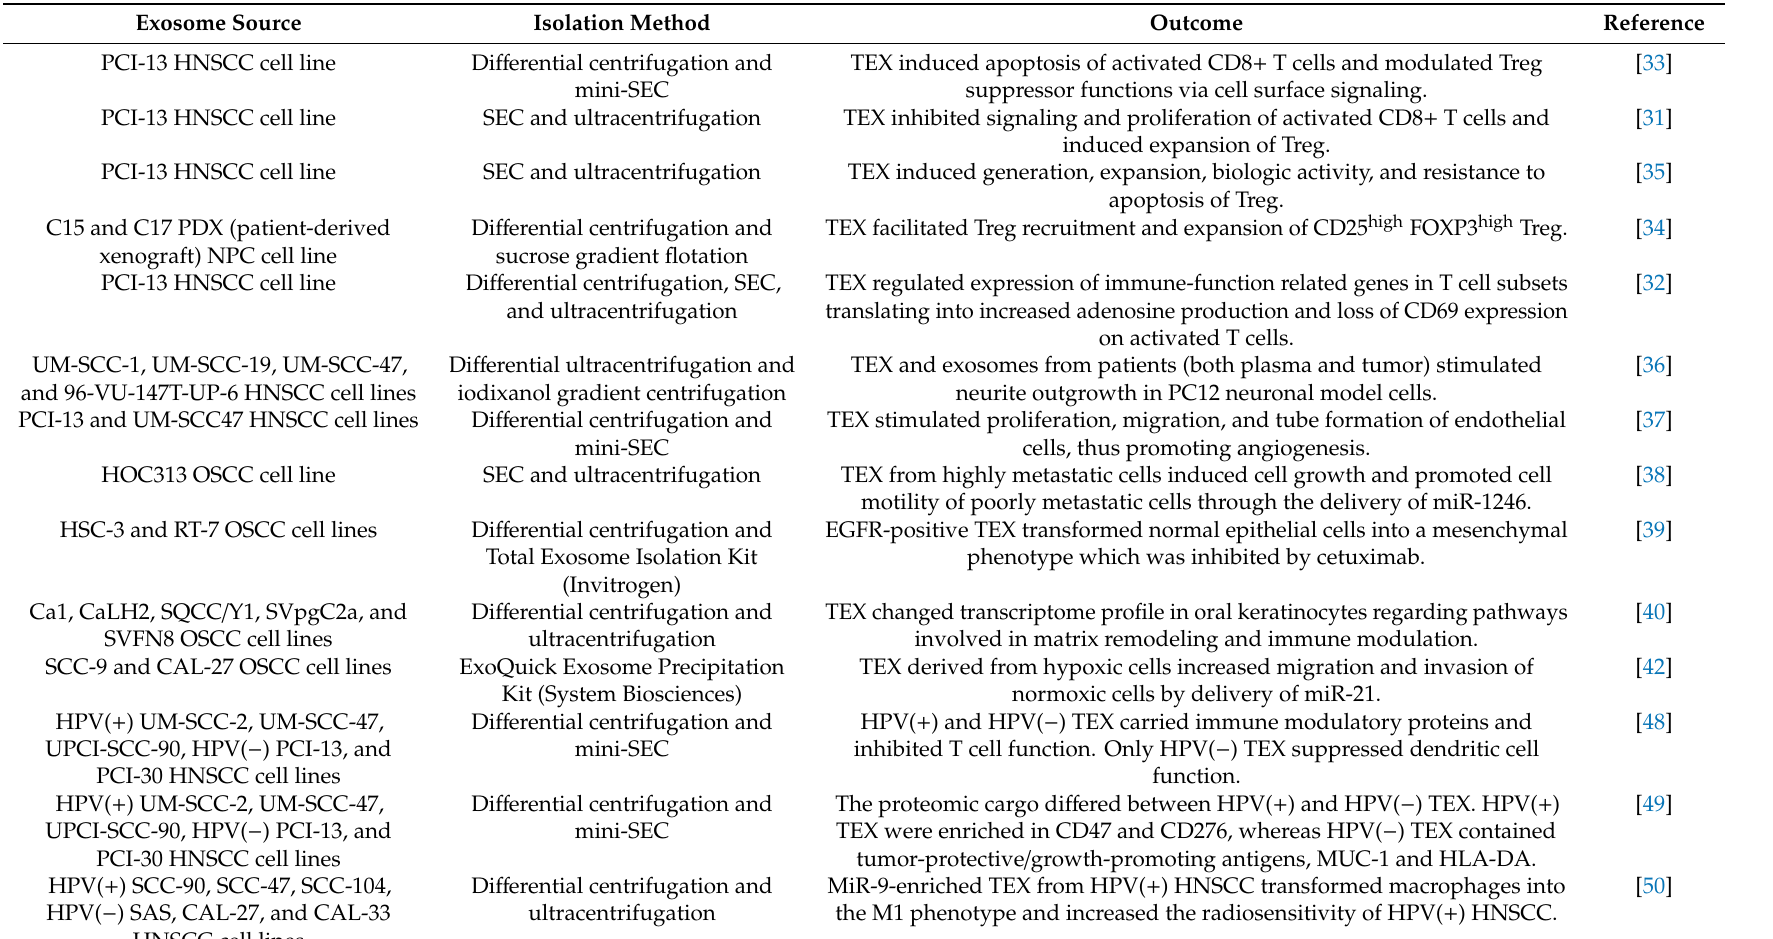
Table 1. E ff ects of exosomes on the tumor microenvironment: in vitro